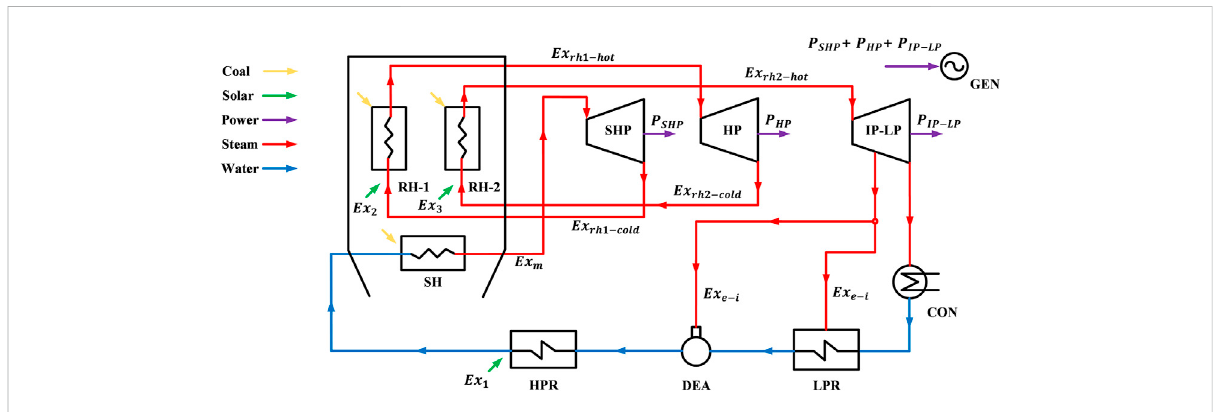
FIGURE 5 Simpli fi ed TSACPG system.